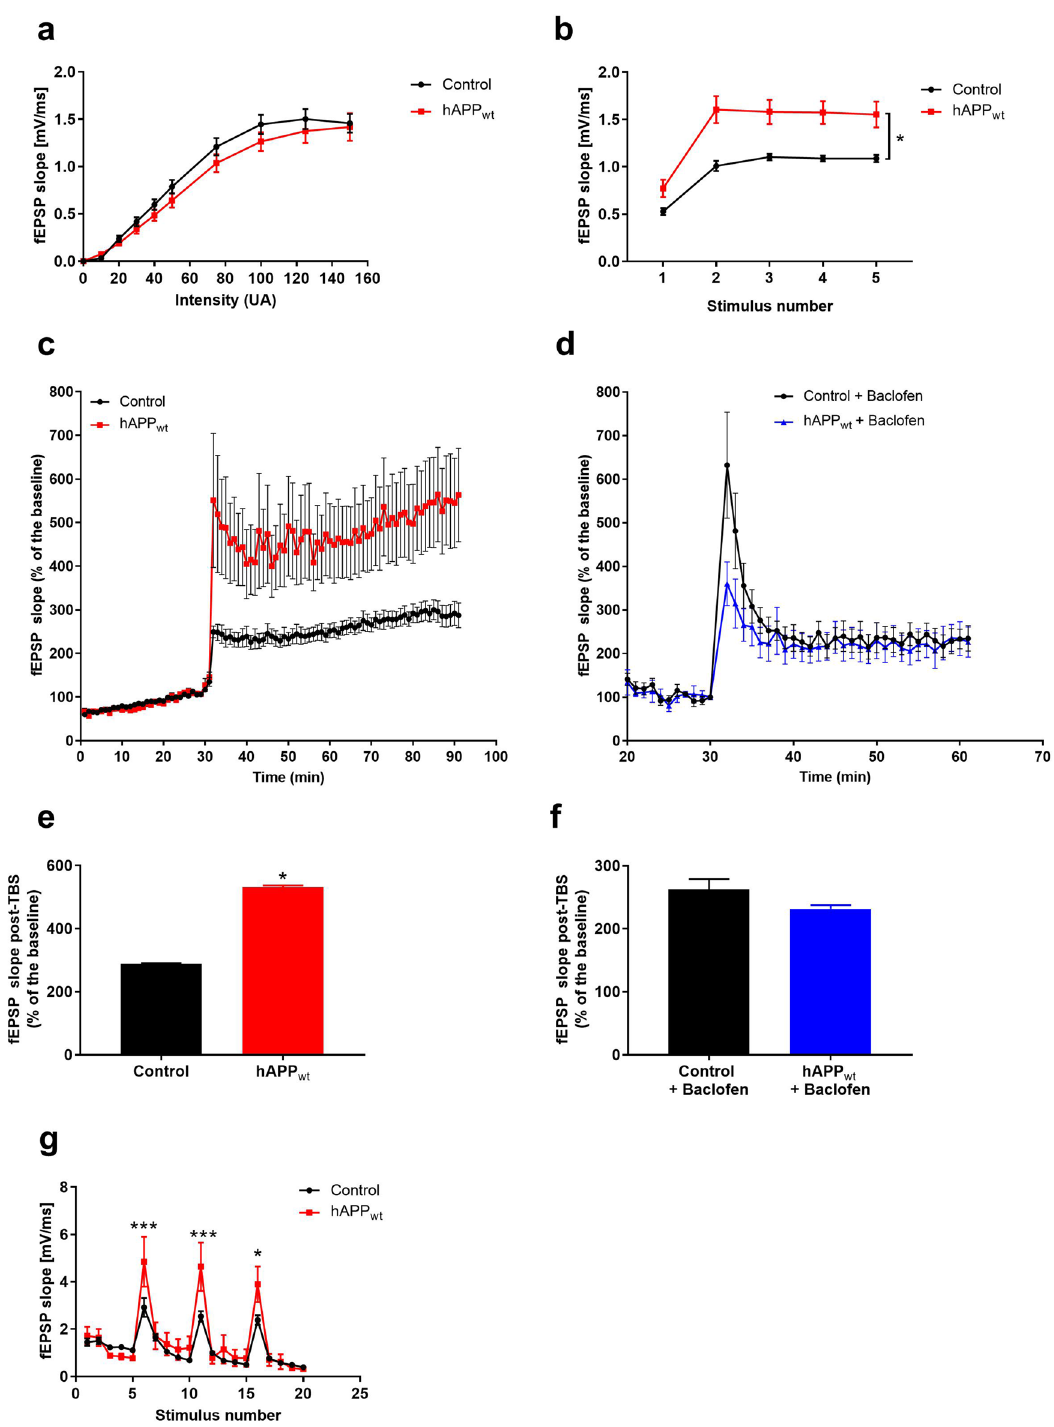
Figure 6. Increased LTP and short-term facilitation in 6 month old male hAPP wt animals. ( a ) Current curves of hAPP wt (n = 51) and controls (n = 48). ( b ) Short-term facilitation at 20 Hz stimulation frequency in hAPP wt (n = 8) brain slices vs. controls (n = 5). ( c ) LTP in hippocampal SC-CA1 pathway electrically stimulated by TBS in hAPP wt (n = 14) compared to controls (n = 12). ( d ) Rescue of increased LTP response in hAPP wt mice (n = 8) compared to controls (n = 7) after perfusion with 100 μM baclofen. ( e ) Quantification of LTP in hippocampal slices of hAPP wt and controls after TBS introduction (corresponding to c ) and ( f ) Quantification of LTP after baclofen perfusion (corresponding to d ). ( g ) Increased fEPSP responses to TBS in hAPP wt (n = 5) animals compared to controls (n = 4). (Values are means ± SEM; *P ≤ 0.05, ***P ≤ 0.001, two-way ANOVA with Sidak’s post-hoc test for b–g , two-tailed unpaired t-test for a